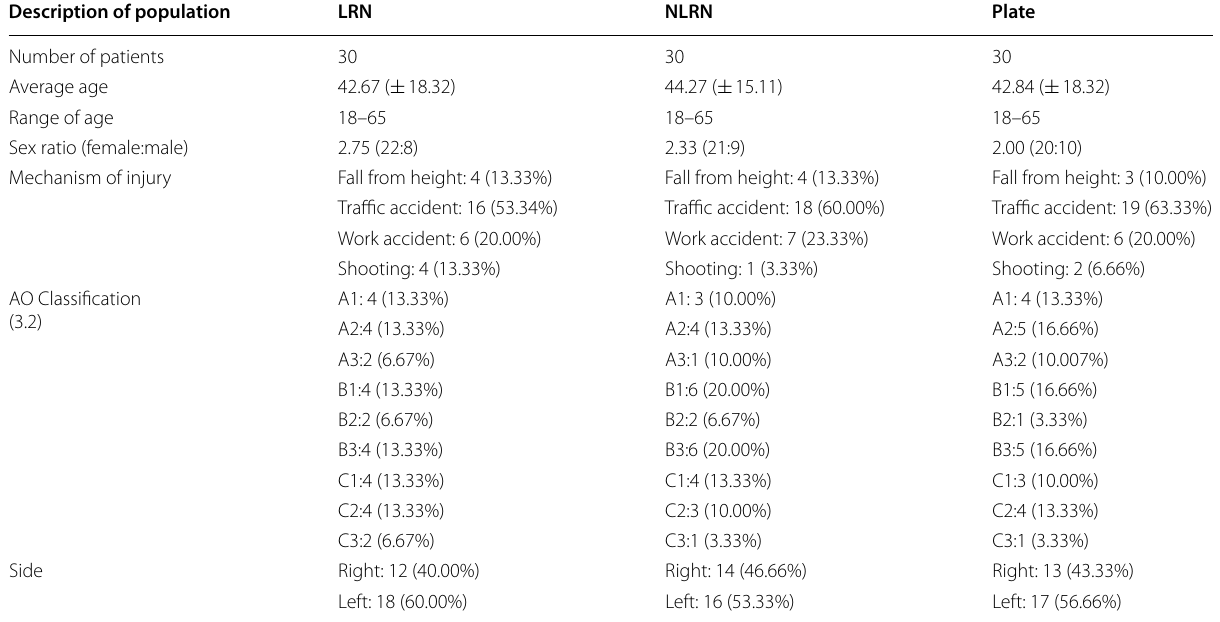
Table 1 Description of the populations Description of population LRN NLRN Number of patients 30 Average